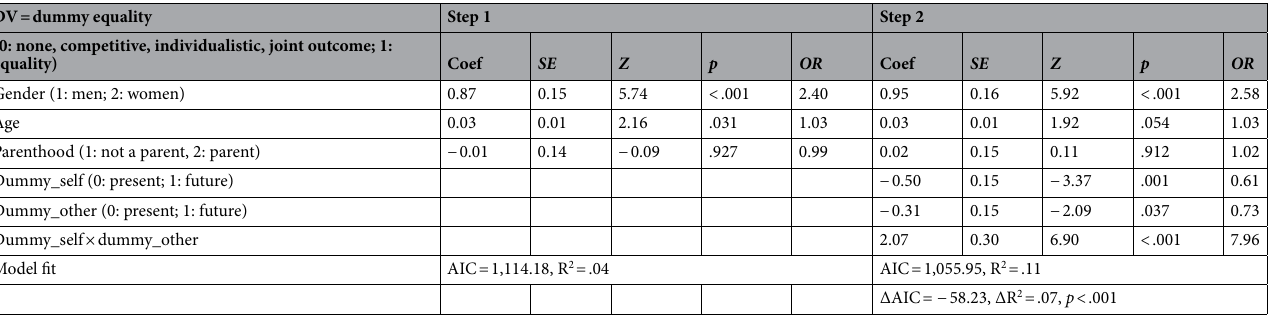
Table 3. Results of logistic regressions for the equality dummy variable. R 2 indicates Cox and Snell R 2 values. Coef. = coefficient; SE = standard error; OR = odds ratio; AIC = Akaike’s information